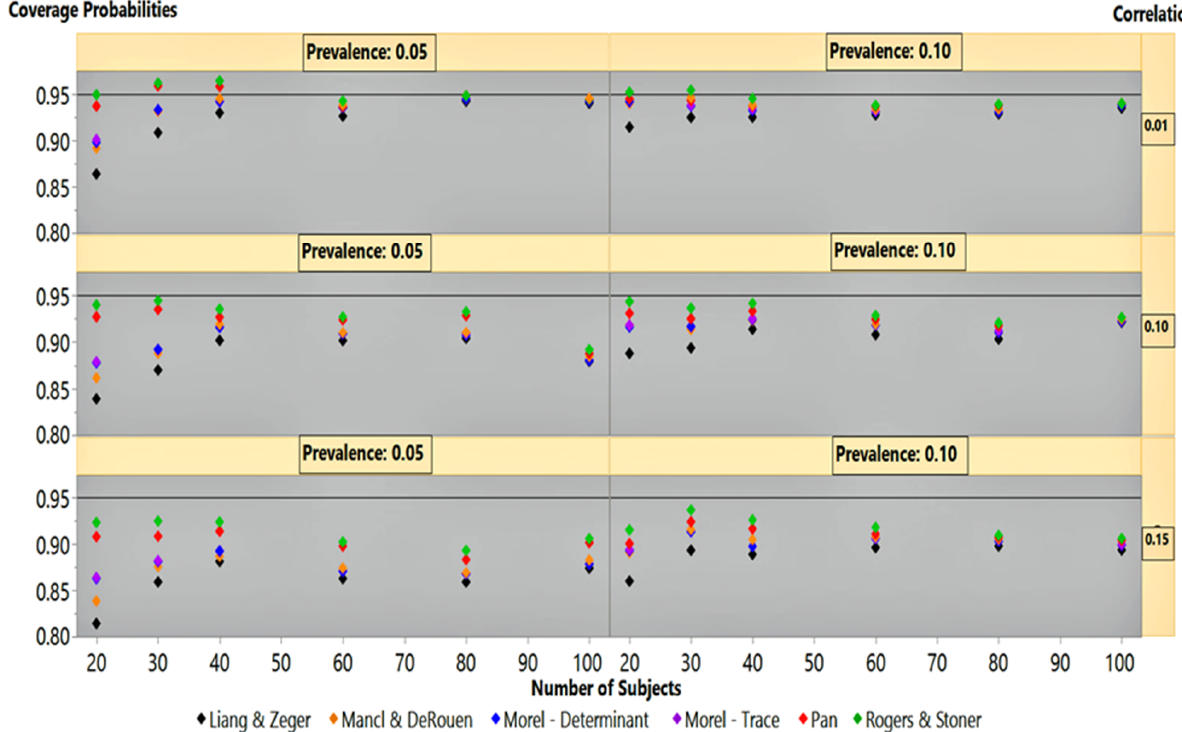
 under a simulated autoregressive 1